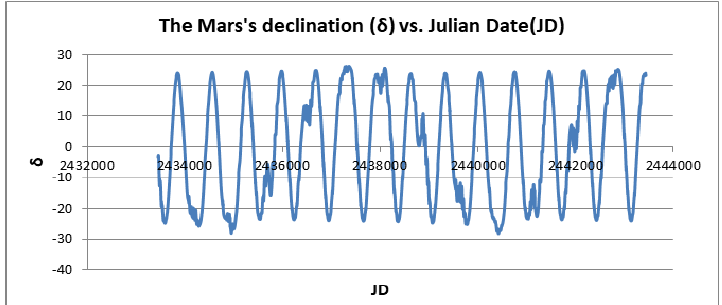
Figure 2: The change of the Mars declination with Julia date during 10000 days